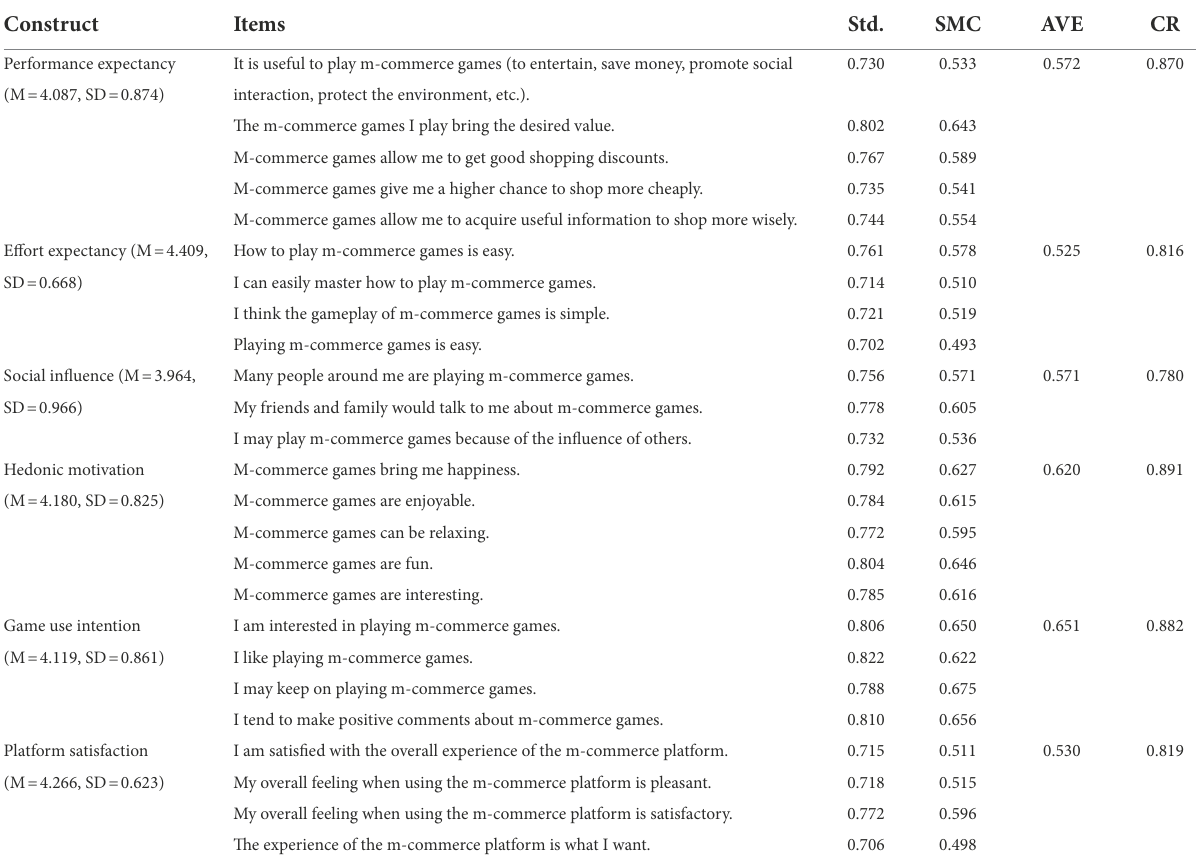
TABLE 1 Summary of factor